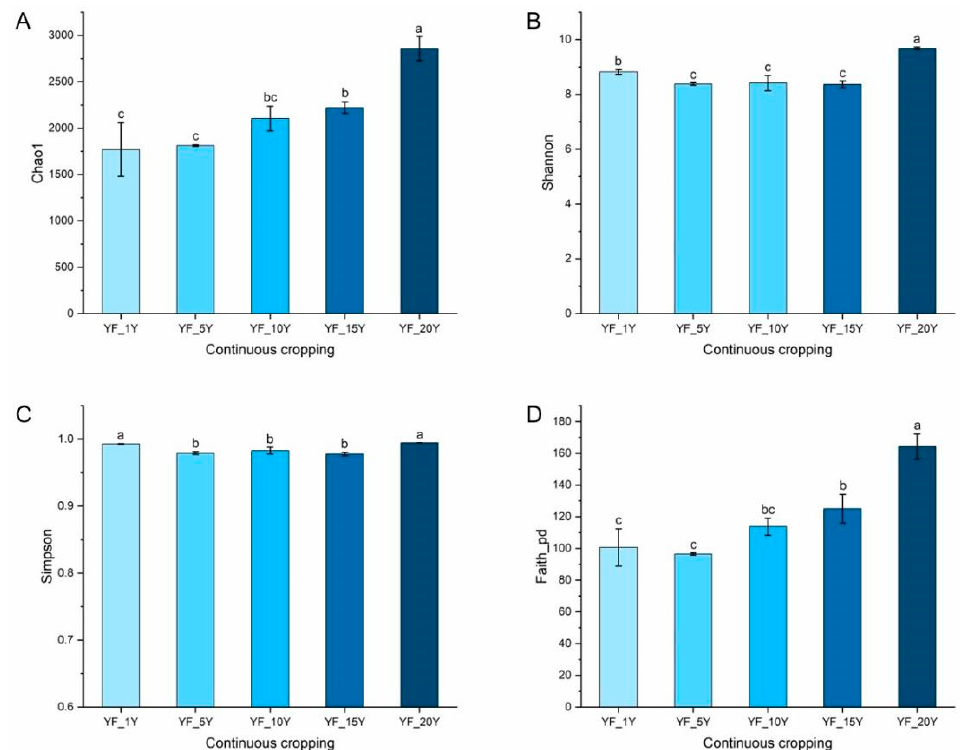
Figure 1. Changes in the alpha diversity indices of the bacterial community among different continuous cropping times of yam. ( A ) Chao1, ( B ) Shannon, ( C ) Simpson, ( D ) Faith_PD. Averages ± SD of samples in each group (with three biological replicates) were expressed in each column. Different letters within a row indicate significant differences at p < 0.05.